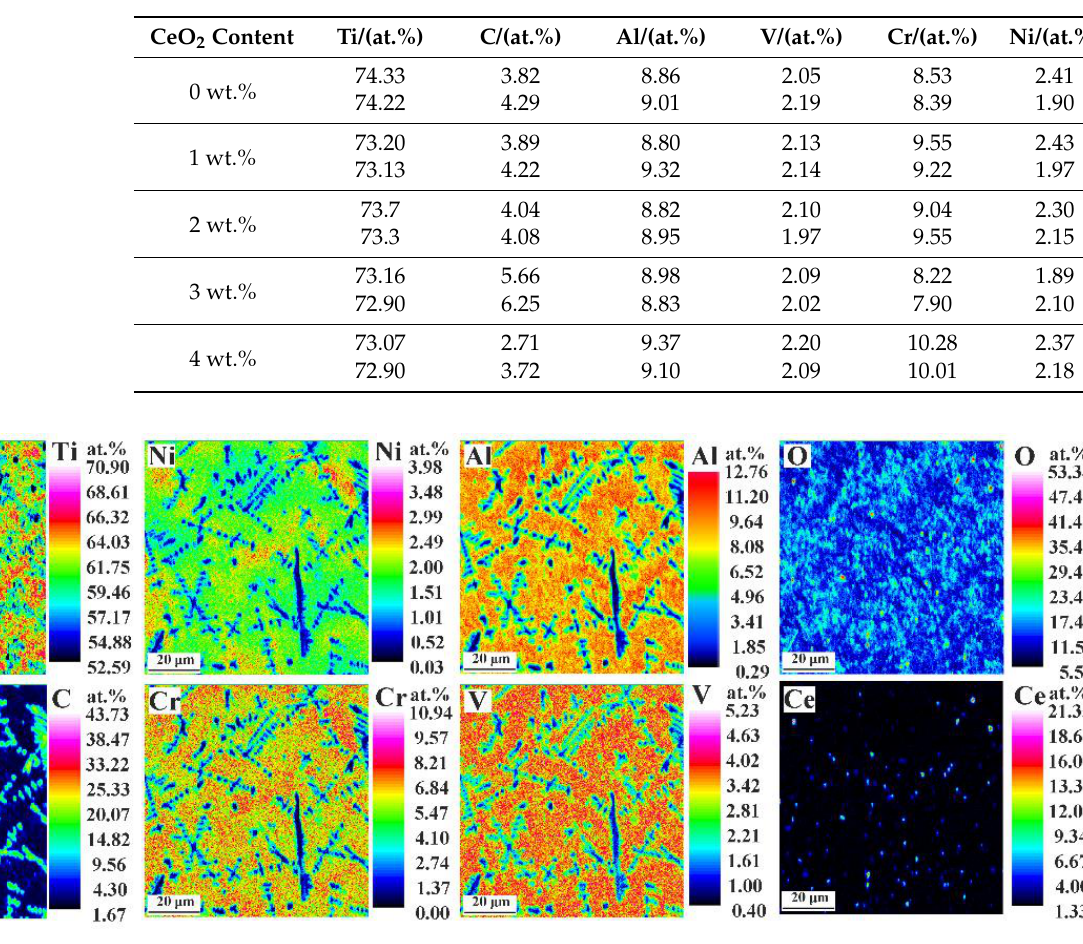
Figure 6. The element distribution of the composite coatings with 2 wt.% CeO 2 .